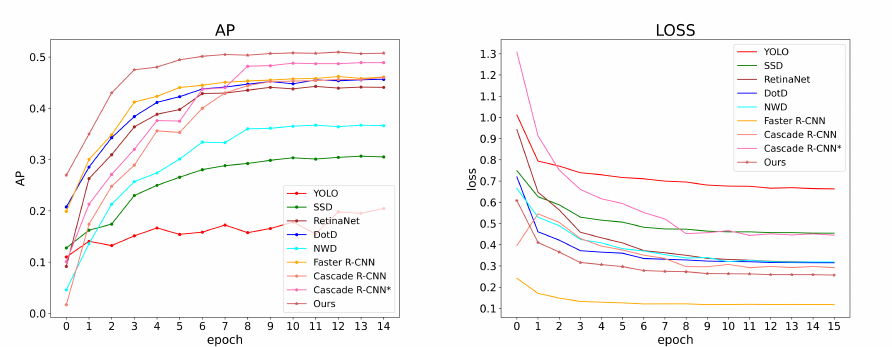
Figure 8. The AP curve ( left ) and training loss curve( right ) on Pest24 dataset; they represent the results of different detectors (the proposed method is marked with